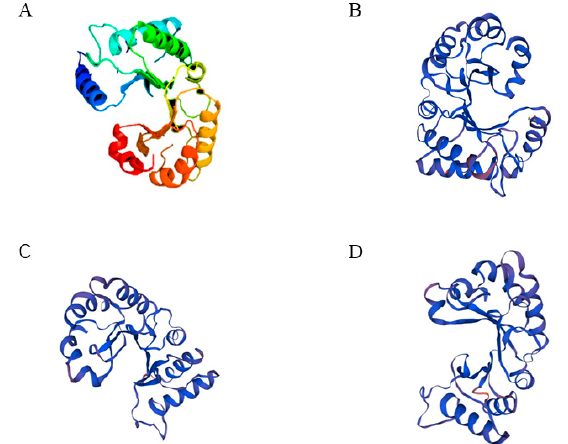
Figure 4. The molecular model of CHI III. ( A ) Pomegranate. ( B ) Bruguiera gymnorrhiza. ( C ) Kandelia obovate. ( D ) Rhizophora stylosa.